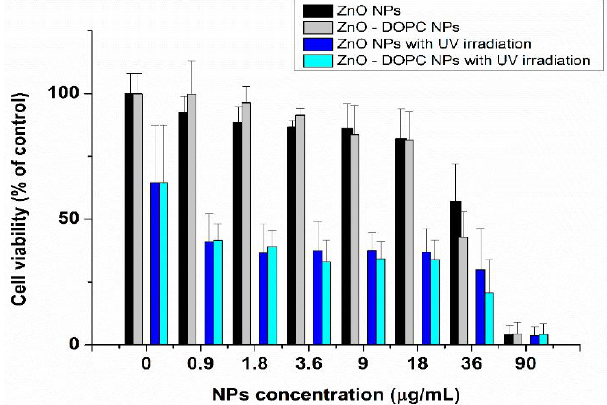
Figure 33. E ff ect of ZnO NPs and lipid coated ZnO NPs of di ff erent concentrations with and without UV irradiation (30 s) on HeLa cell viability. Reproduced from [170] under the Creative Commons Attribution